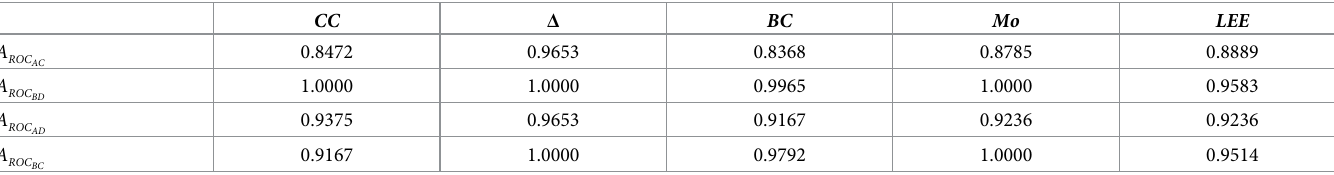
Table 2. Areas under the ROC curves (A ROC ) of the network measures CC, Δ , BC, Mo, and LEE, for patients in groups A and C, B and D, A and D, and B and C for k max = 9, 10, 6, 6 and 8,